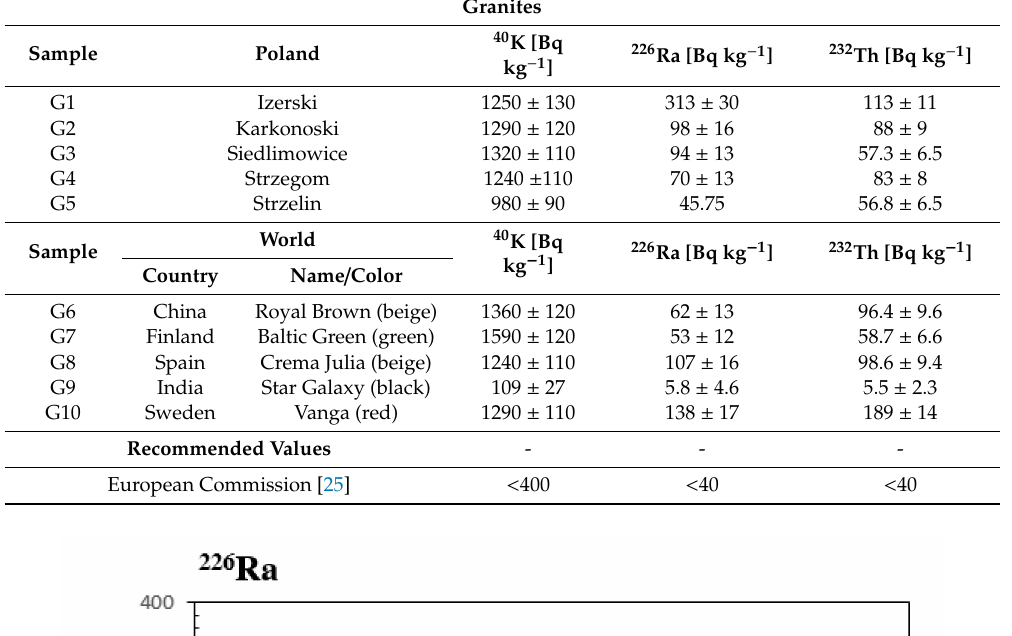
Table 1. The activity concentration of the natural isotopes of potassium 40 K, radium 226 Ra and thorium 232 Th taking into account the uncertainty estimated by dedicated software.